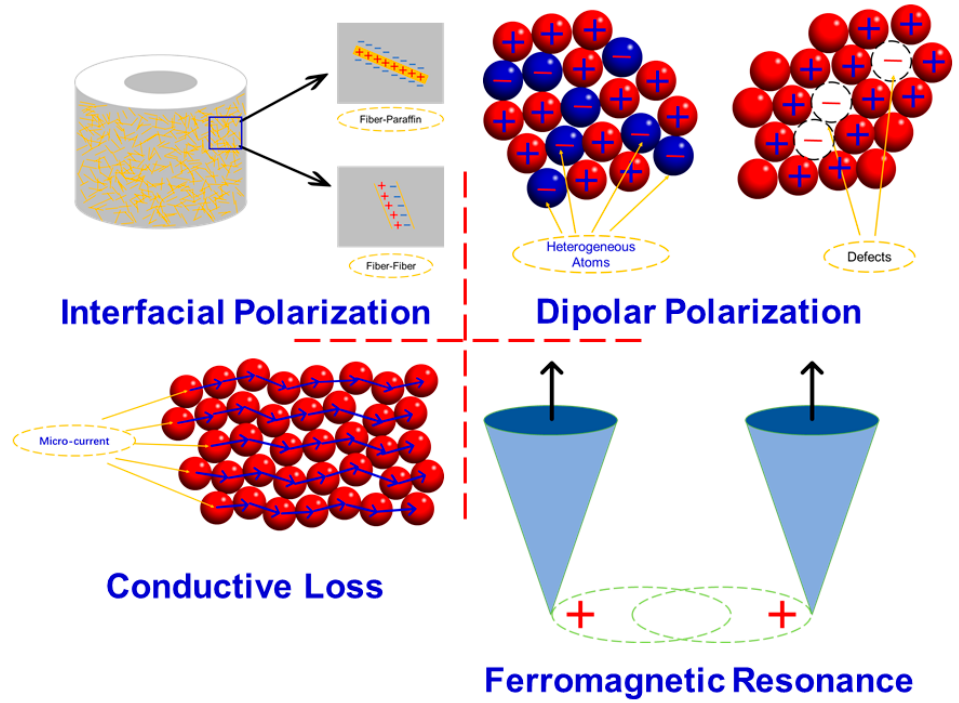
Figure 10. Schematic diagram of the electromagnetic loss mechanisms of Fe–based metallic